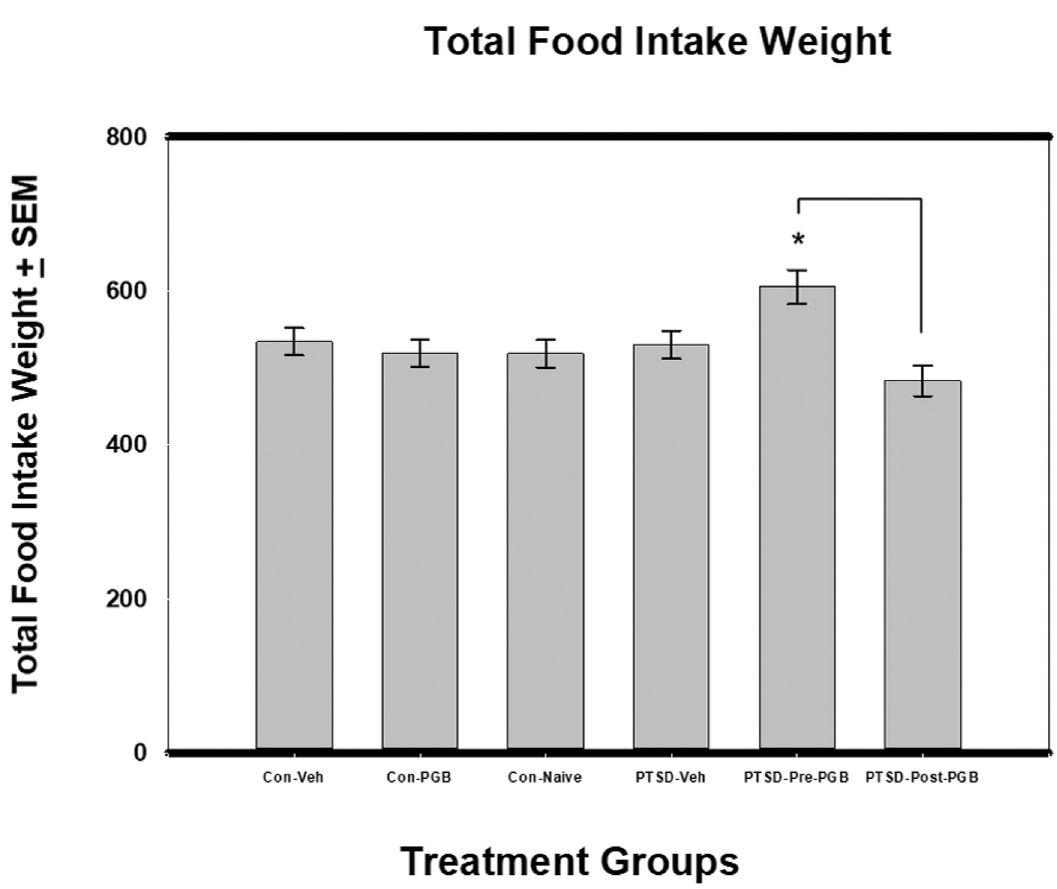
Fig 3. ANCOVA for total food intake weight. Each of the main two groups (Stressed and Non-stressed) had three subgroups: non- stressed: control vehicle, control PGB, control na ï ve, and stressed: Posttraumatic stress disorder (PTSD) vehicle, PTSD Pre-PGB (prophylactic), PTSD Post-PGB (non-prophylactic). Mean total food intake weight is reported with the SEM. Asterisks denote statistical significance at p < .05. PTSD-Pre-PGB was significantly higher than the